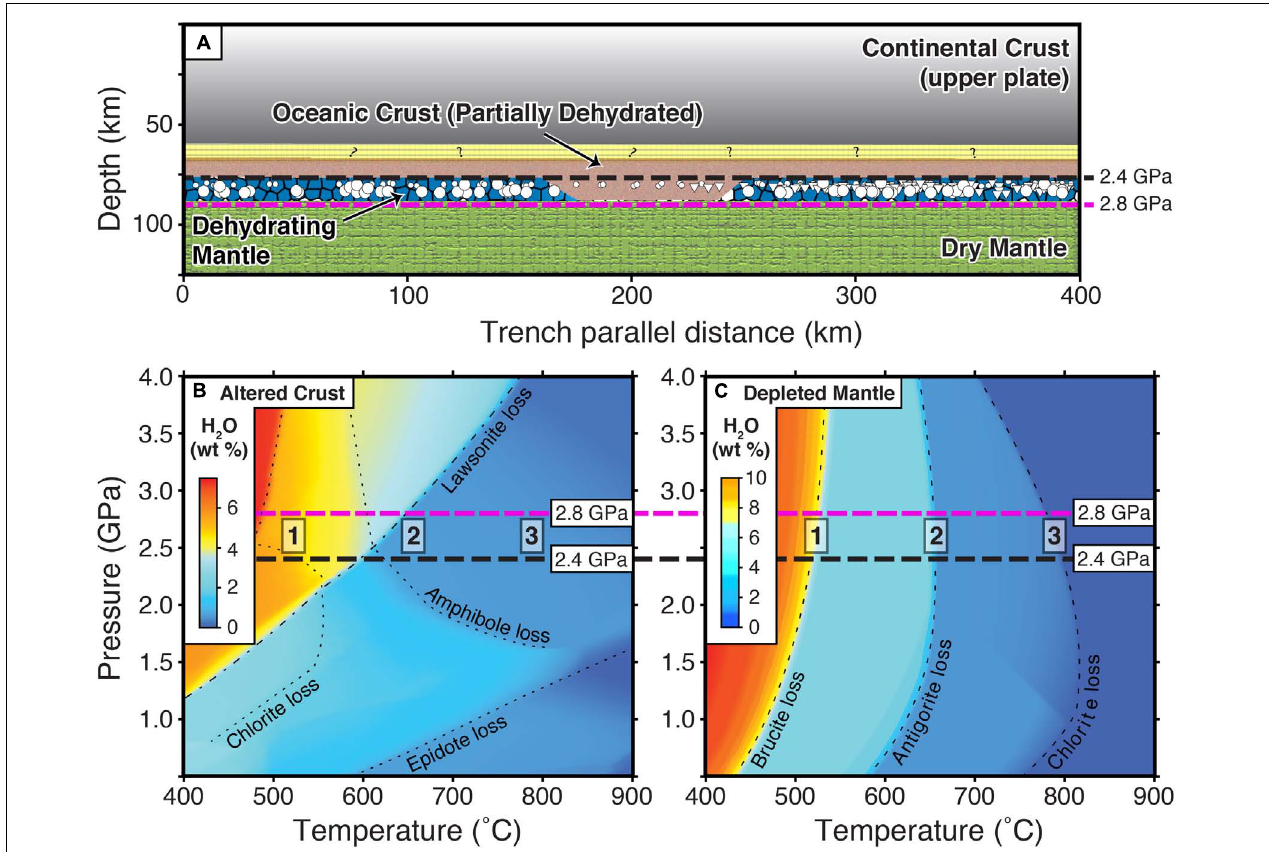
FIGURE 2 | Schematic diagram of our hypothesis: (A) Simplified trench-parallel cross section based on geometry shown in Figure 1 . Section has been simplified so that the plate is perfectly flat across the interior 400 km ( ∼ 150 km on either side of the ridge) and so that all seismicity is projected to the depth range of our proposed hydrated mantle lithosphere (lateral distribution still the same as in the cross section in Figure 1 ). Green region indicates dry oceanic mantle lithosphere. Blue indicates hydrated oceanic mantle lithosphere. White circles/triangles are seismic events (same symbols as in Figure 1 ). Light brown region is oceanic crust (MORB). Yellow region indicates possible mantle material trapped between the oceanic crust and the overlying continental crust (grayscale). Black dashed line is depth to the base of “normal” oceanic crust (i.e., top of hydrated mantle lithosphere). Magenta line is proposed maximum depth of hydration into the oceanic plate. Bottom: Mineralogically bound H 2 O contents of hydrated MORB (B) and peridotite (C) , based on phase equilibria calculations. Dashed lines show pressures corresponding to lines of the same color in the cross section above. Boxes 1, 2, and 3 indicate regions where oceanic mantle undergoes significant dehydration at pressures experienced by hydrated mantle lithosphere. Versions of these diagrams labeled with the mineral assemblages associated with the H 2 O contents are available in Supplementary Information